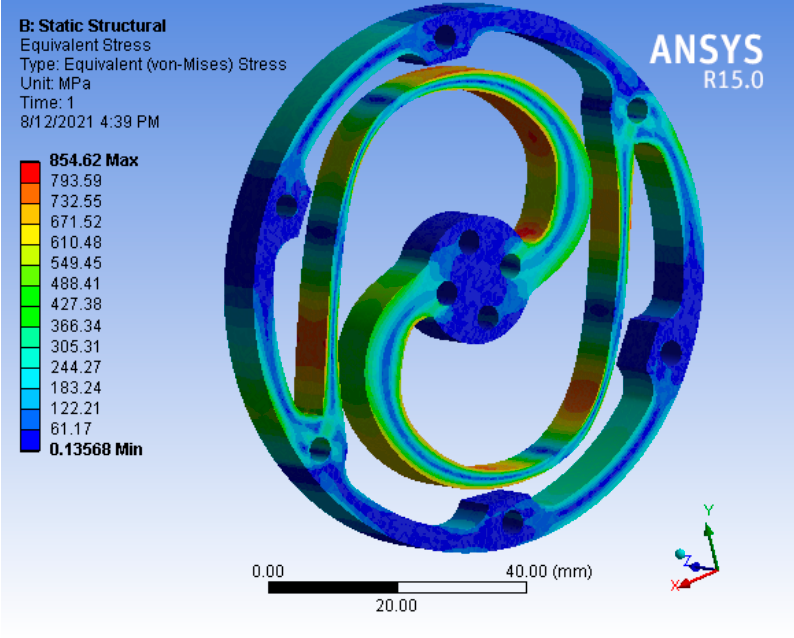
Figure 6. FEM-design for planner torsion spring.